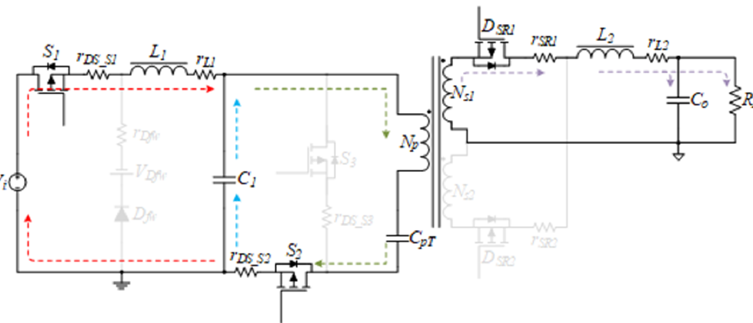
Figure 15. Equivalent circuit operating during [0, DT ].